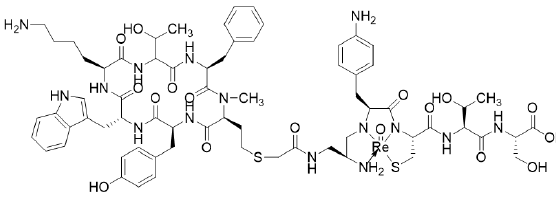
Figure 11. [ 188 Figure 11. [ 188 Re]-P2045.